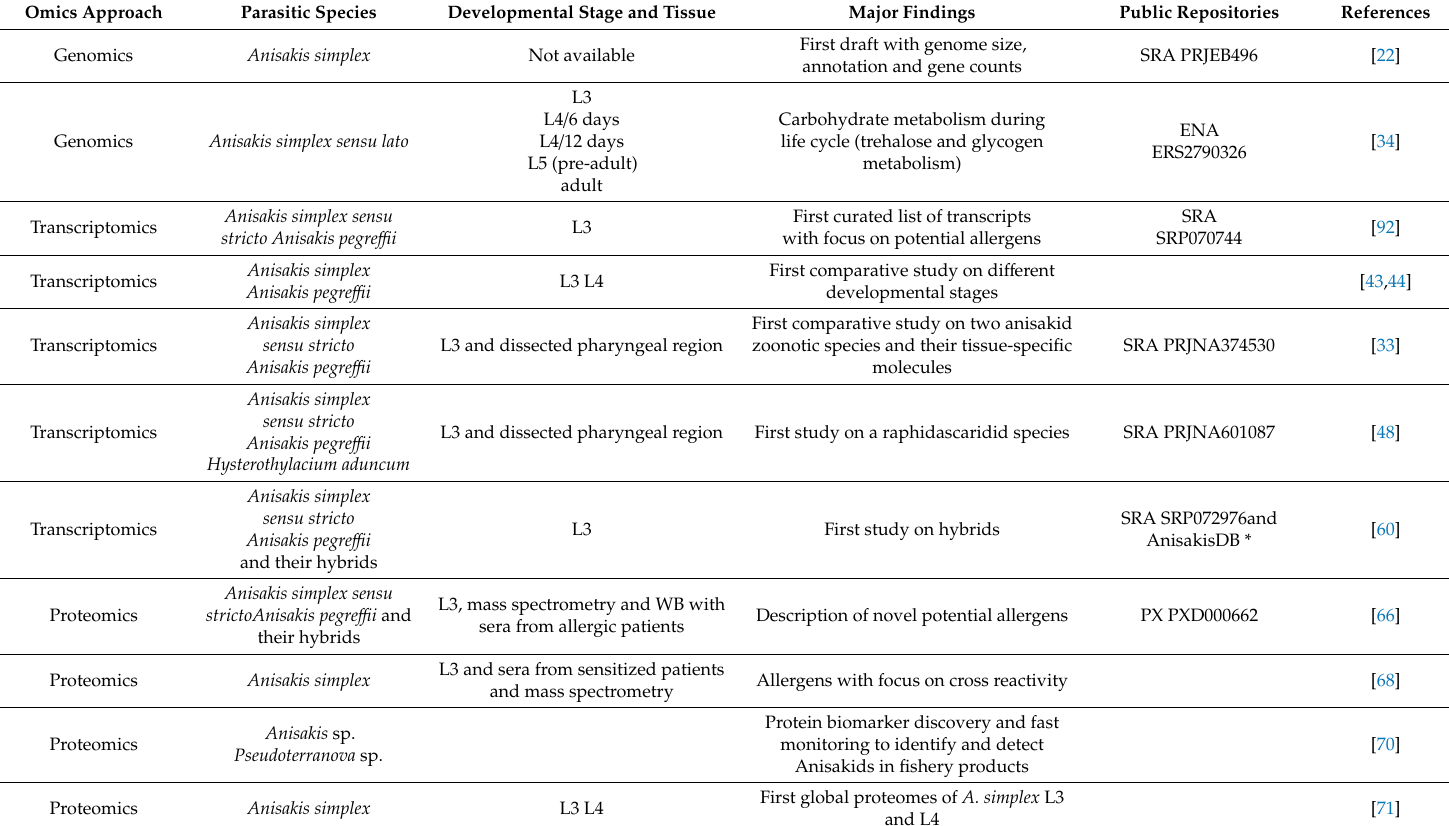
Table 2. List of available omics studies on anisakids. Genomics, transcriptomics, and proteomics studies on anisakids with information on parasitic species analyzed, developmental stage or tissue, major findings, accession number of available data in public repositories, and references. * AnisakisDB is available